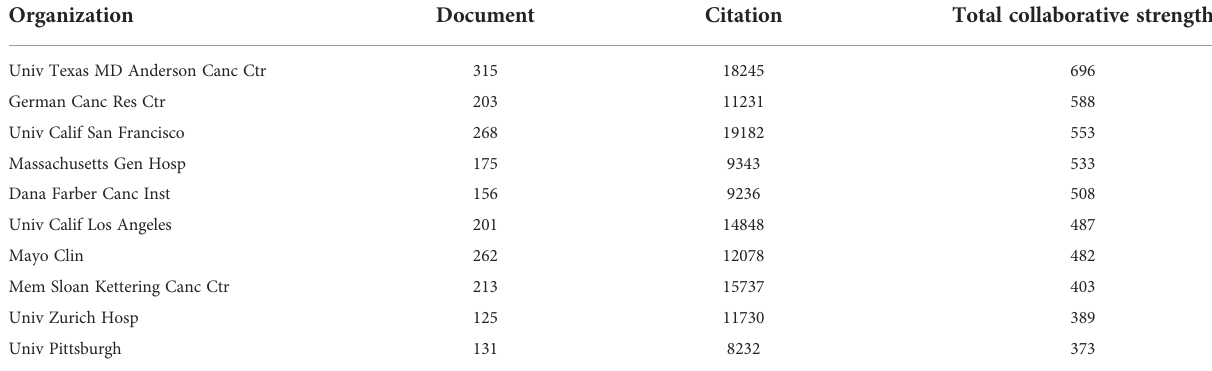
(Figure 7). The top four funding agencies, including the USA